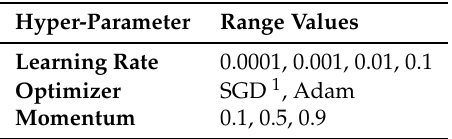
Table 1. Set of hyper-parameters values considered in the search for the CAE training.